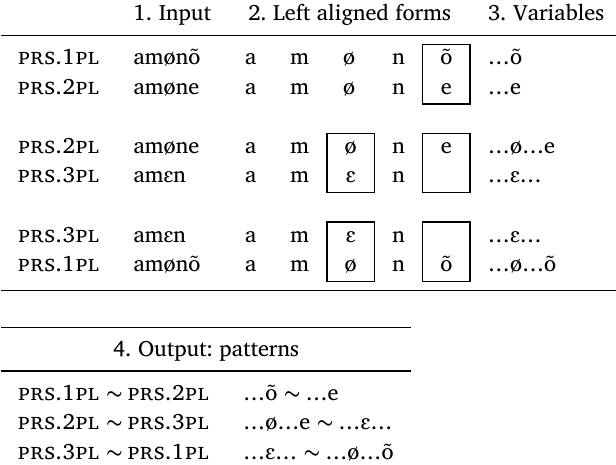
Plural present forms for the verb amener ‘bring’: Local pattern